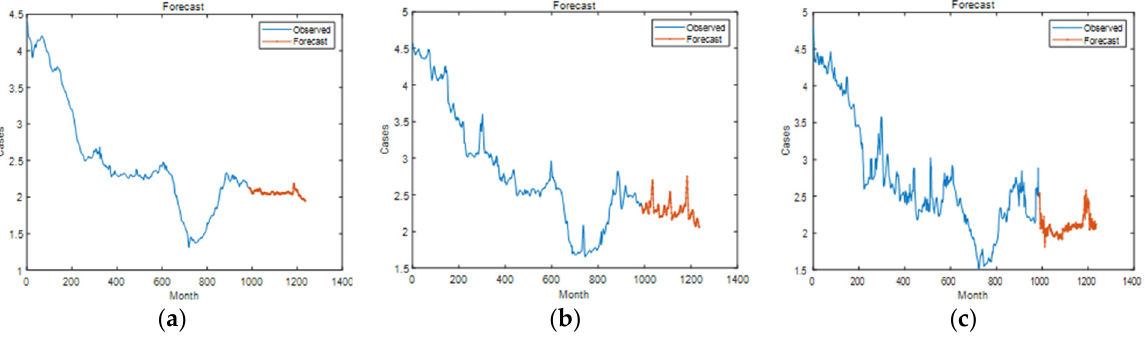
Figure 2. Training–test results. ( a ) the THIRD; ( b ) the BANK; ( c ) the FUND.